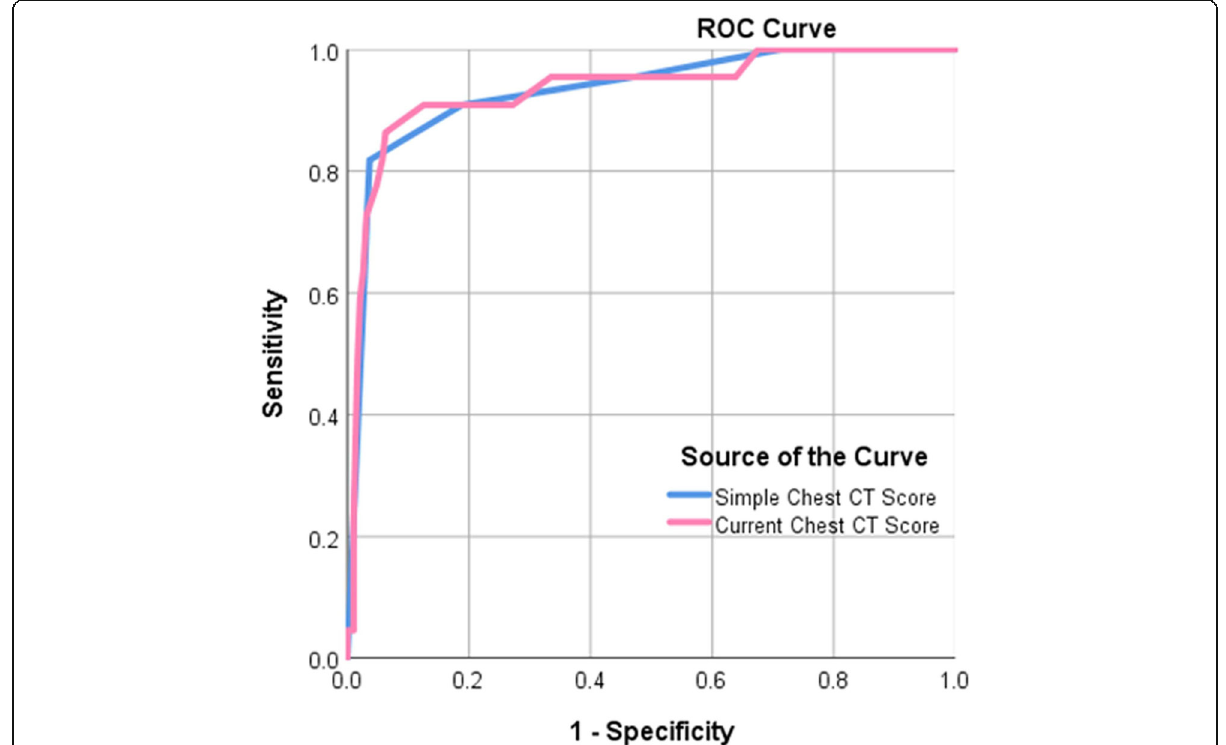
Fig. 7 Receiver operator characteristic (ROC) curve for chest CT scores in predicting mortality